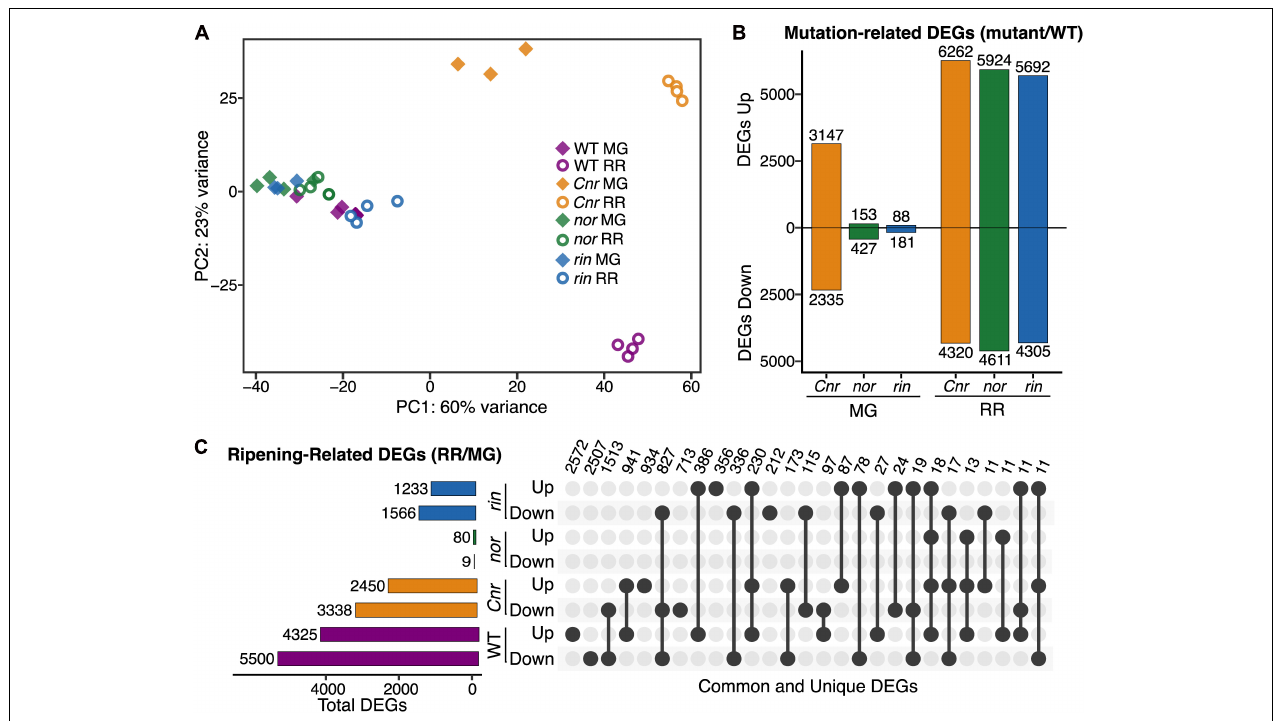
FIGURE 2 | Transcriptional misregulation in fruit from the single ripening mutants Cnr, nor , and rin . (A) Principal component analysis of total mapped RNAseq reads for Cnr , nor , rin and wild type (WT) fruit at the mature green (MG) and red ripe (RR) stages. (B) Number of differentially expressed genes (DEGs; P adj ≤ 0.05) up- or down-regulated for each mutant compared to WT. (C) Total, unique, and intersecting up- and down-regulated DEGs across ripening (RR/MG) for each genotype visualized using UpSetR . Dots connected by lines indicate common DEGs between categories and single dots indicate unique DEGs, with the number of genes in each category listed